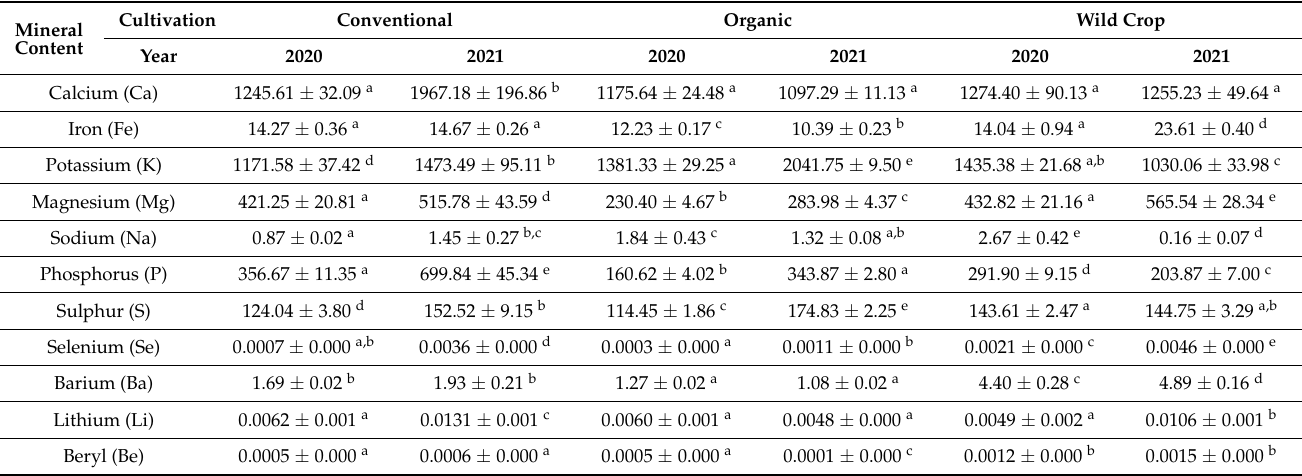
Table 6. Selected minerals in leaves of raspberries from conventional and organic practices as well as those wild grown (mg 100 g − 1